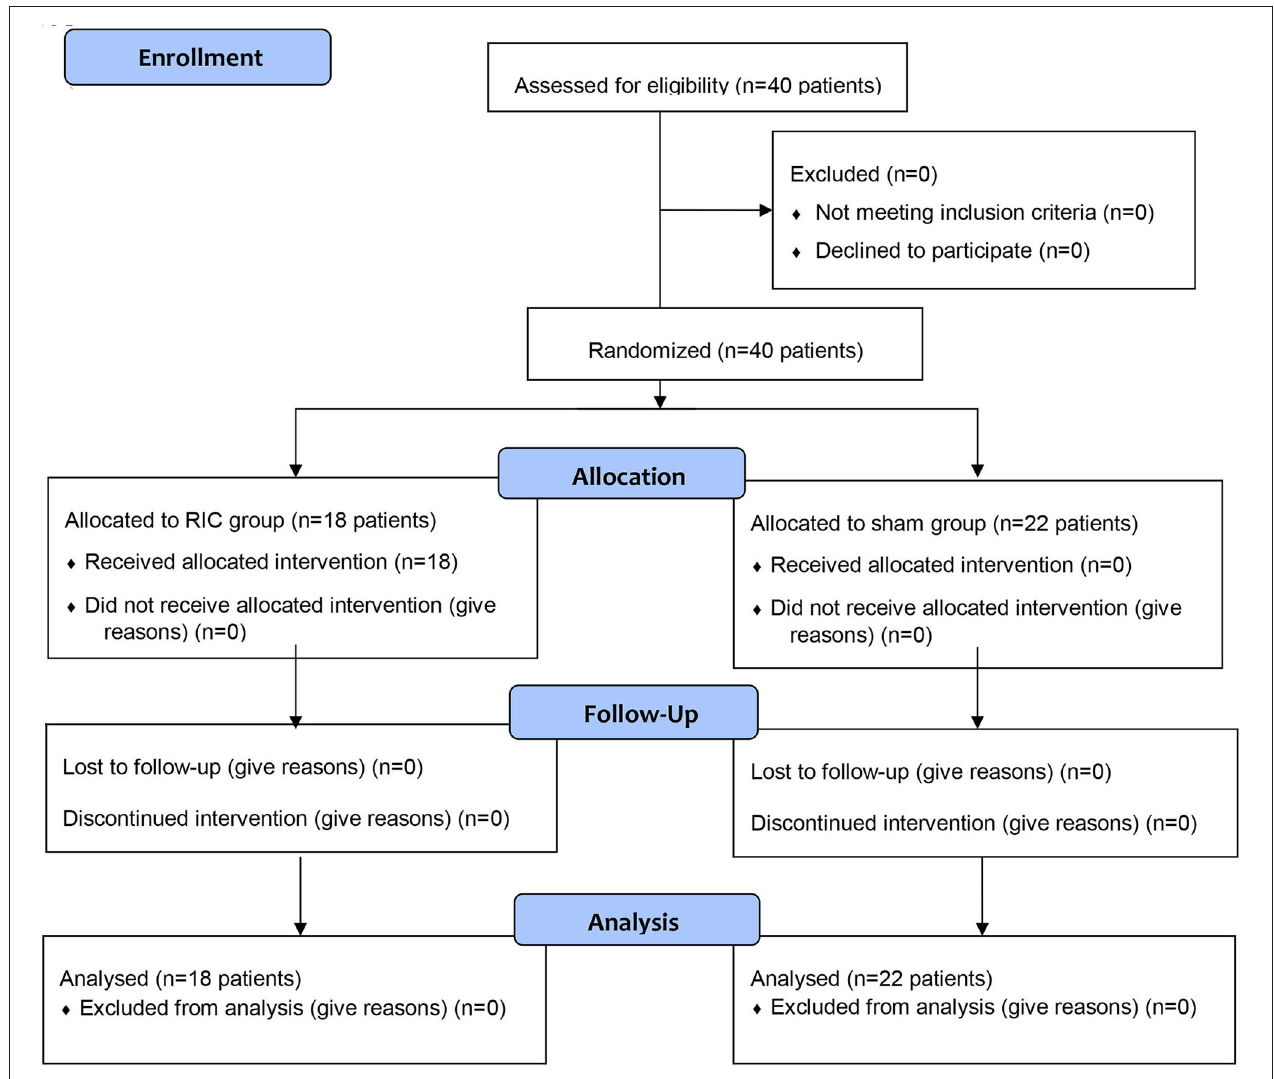
FIGURE 1 | CONSORT flow chart showing the selection process of patients.